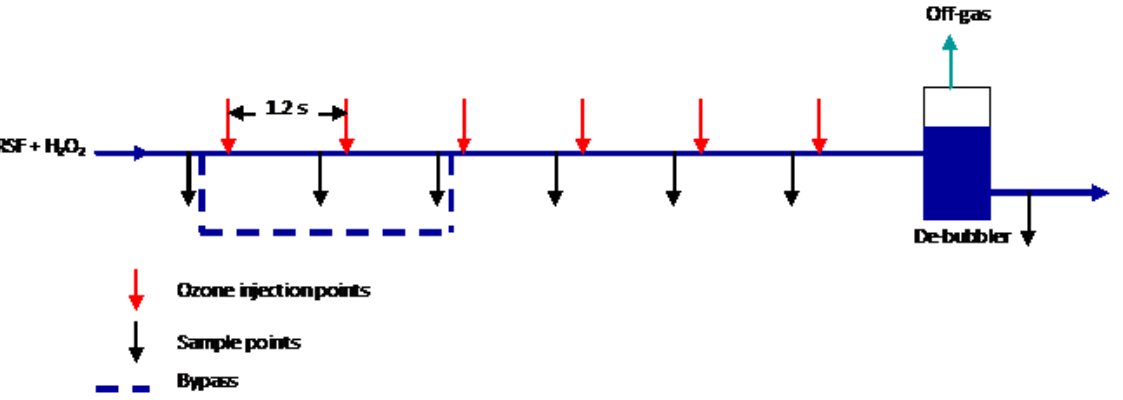
Figure 2. Schematic loop reactor.